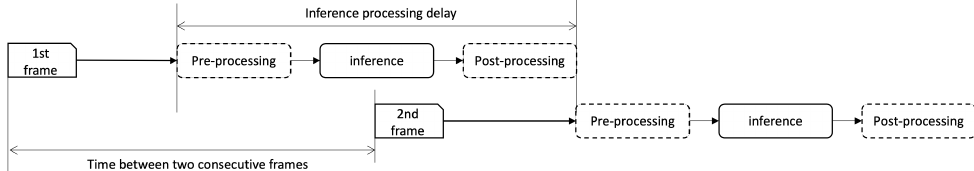
Figure 2. Real-time video analysis application. If inference processing delay is bigger than the time between two consecutive frames, the output will be